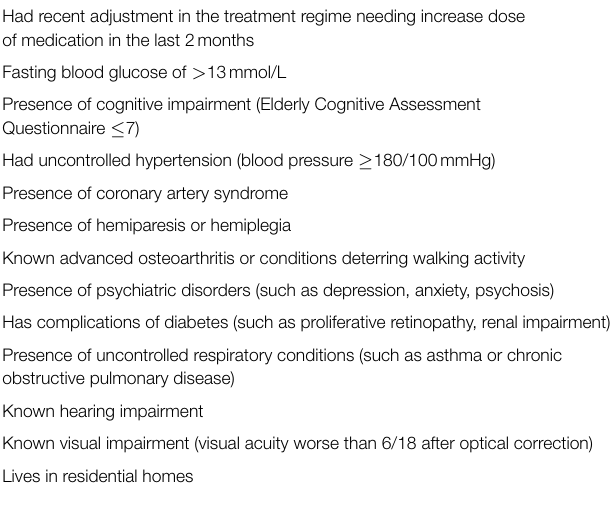
TABLE 1 | Exclusion criteria for participant recruitment